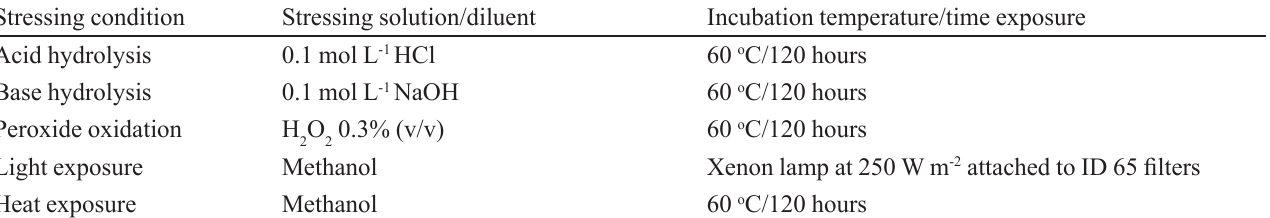
TABLE II - Forced degradation samples Stressing condition Stressing solution/diluent